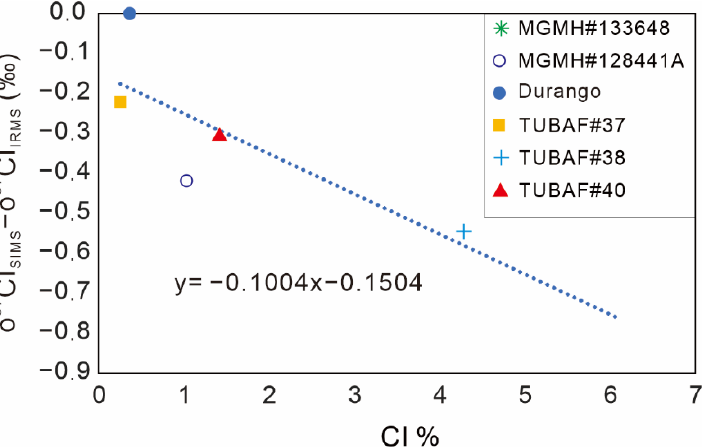
Figure 3. Matrix effect caused by the varying Cl content in different samples. A linear trend was found between ΔIMF Cl ( δ 37 Cl SIMS −δ 37 Cl IRMS ) and Cl% in samples.